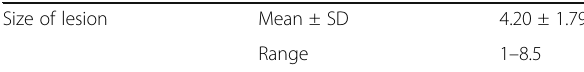
Table 2 Statistical data analysis of the size of the